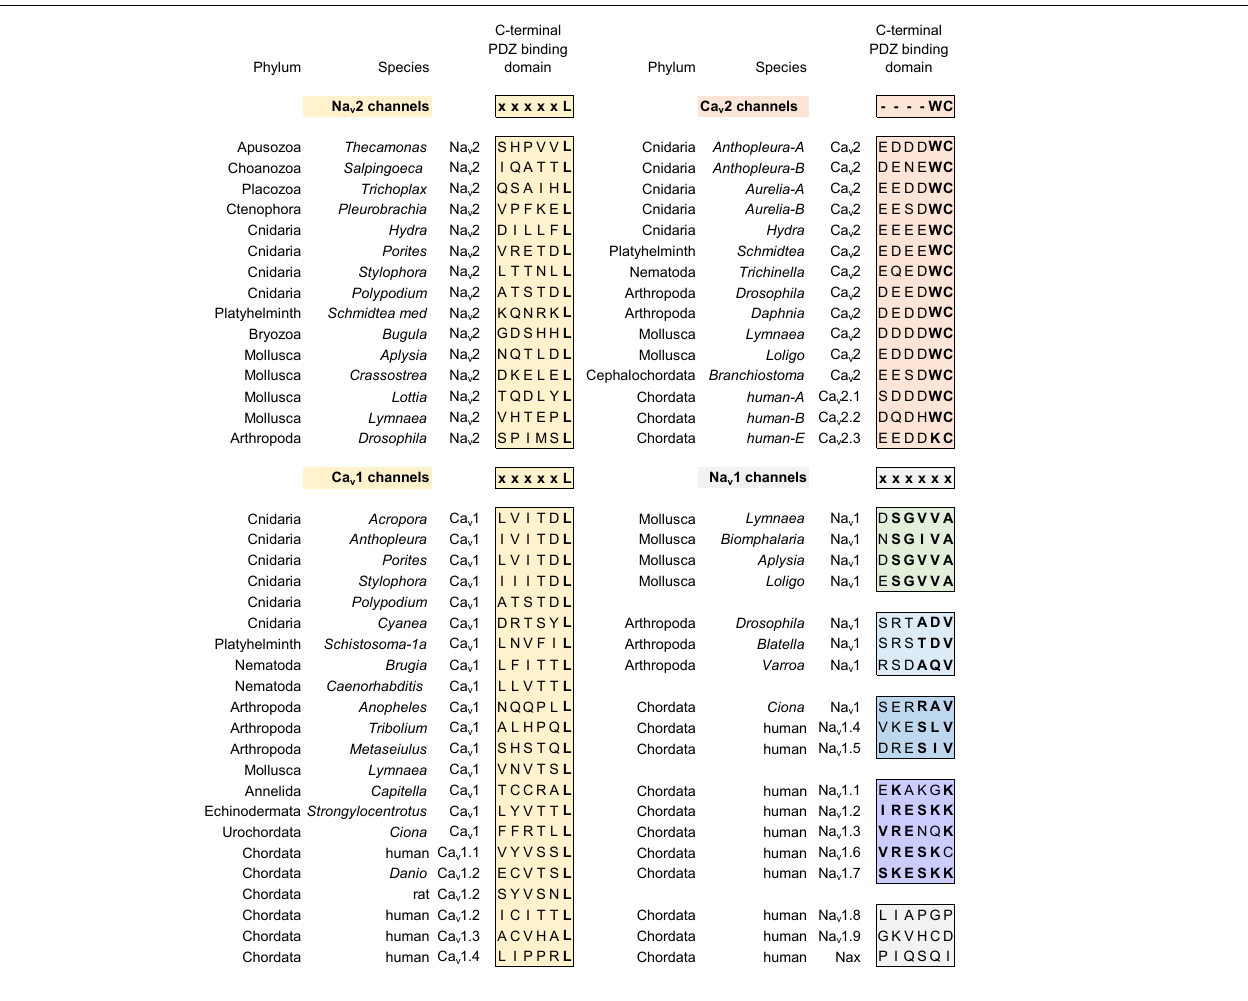
protein targeting of Na v 1.5 and K v channels to the lateral cardiomyocyte membrane specifically, without influencing their location at intercalated disks (Shy et al., 2014). This C-terminal PDZ binding motif also appears to protect Na v 1.5 channels from proteosomal degradation within cardiomyocytes (Shy et al., 2014). C-terminal PDZ binding motifs are not always